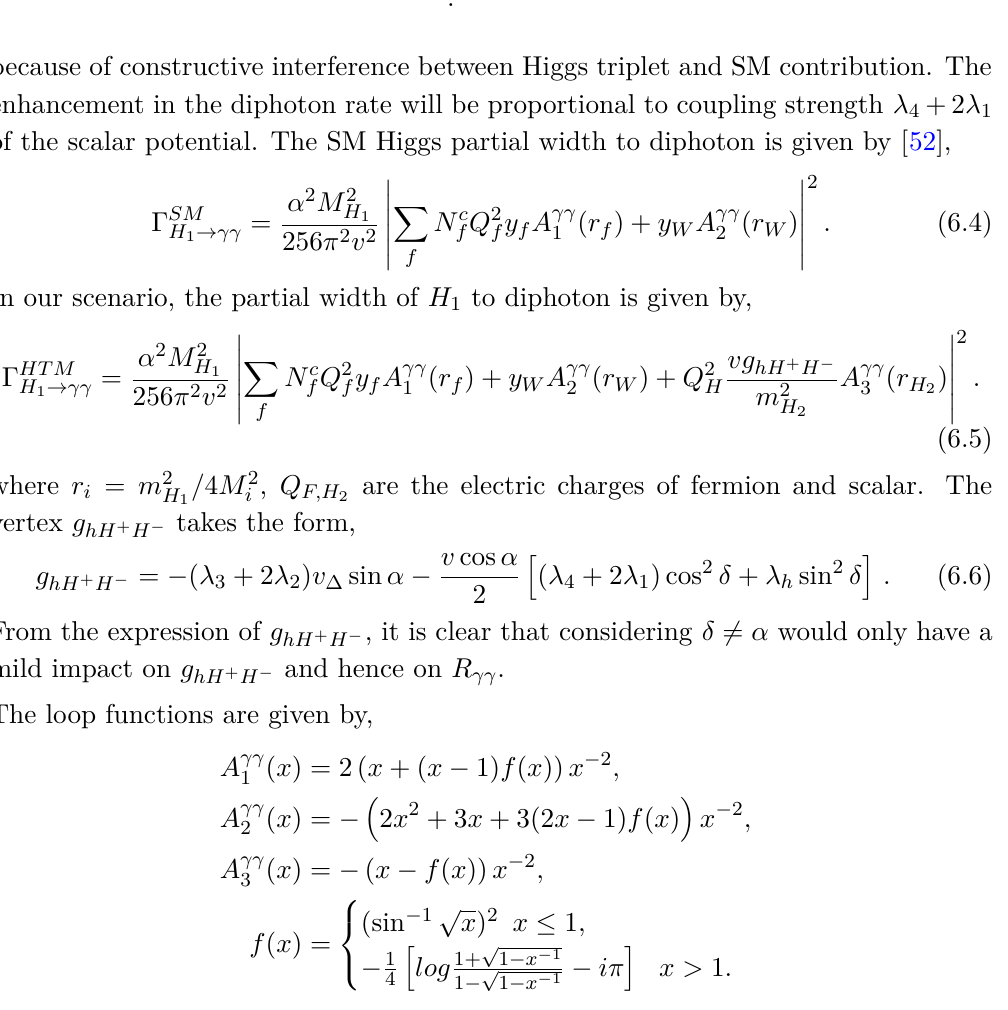
Figure 25 . Branching fractions for H 2 and H + for different masses of H 2 .